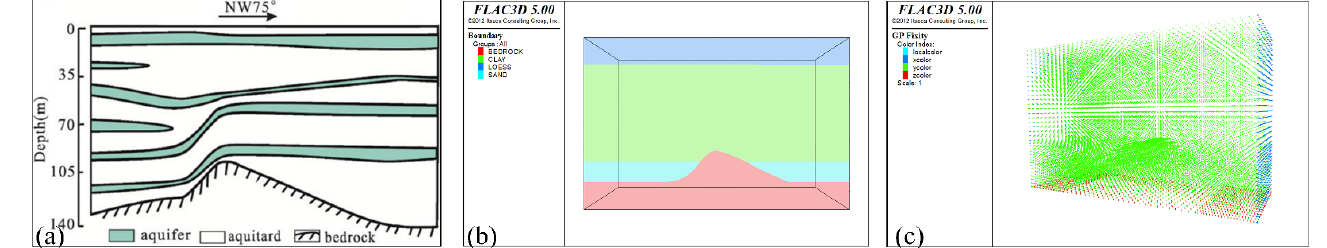
Figure 10. ( a ) Stratigraphic cross section. ( b ) Model based on actual bedrock fluctuations. ( c ) Boundary condition setting. Table 2. Physical parameters of each soil layer. Value Parameter Loess Clay Sand